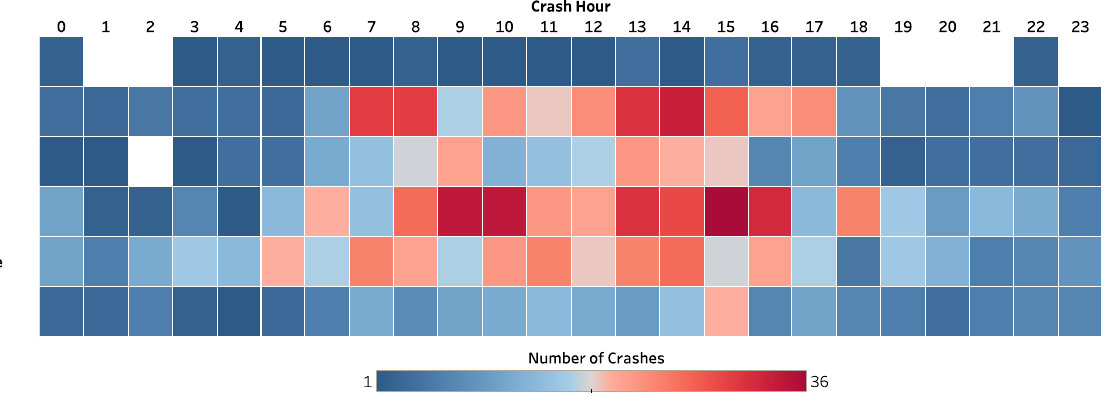
Figure 7. The number of HAZMAT road transportation crashes by collision type and crash